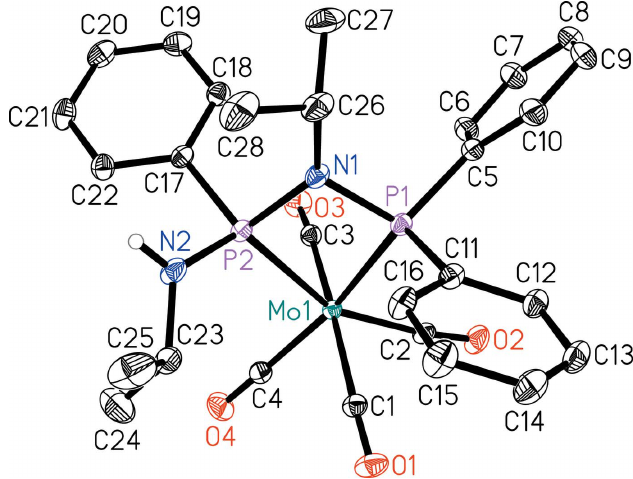
Figure 1 The molecular structure of the title compound with atom labelling and displacement ellipsoids drawn at 30% probability level. C-bound hydrogen atoms are omitted for